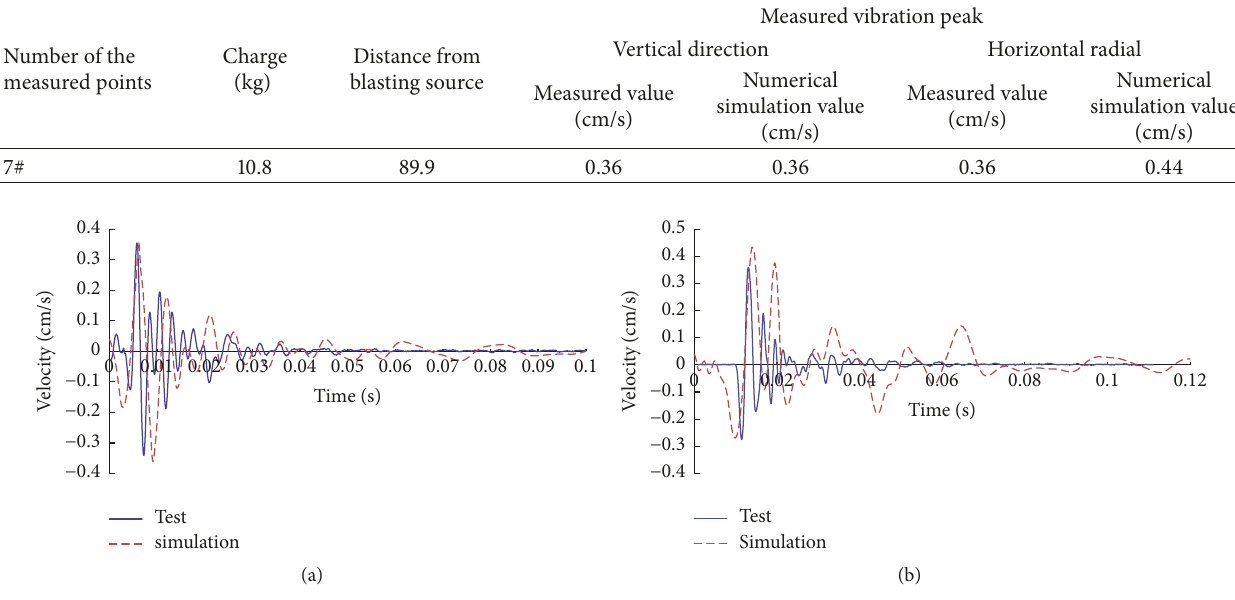
Figure 5: The comparison of the vibration velocity of the 7# measured point between the numerical calculated value and measured value: (a) vertical direction and (b) horizontal direction.